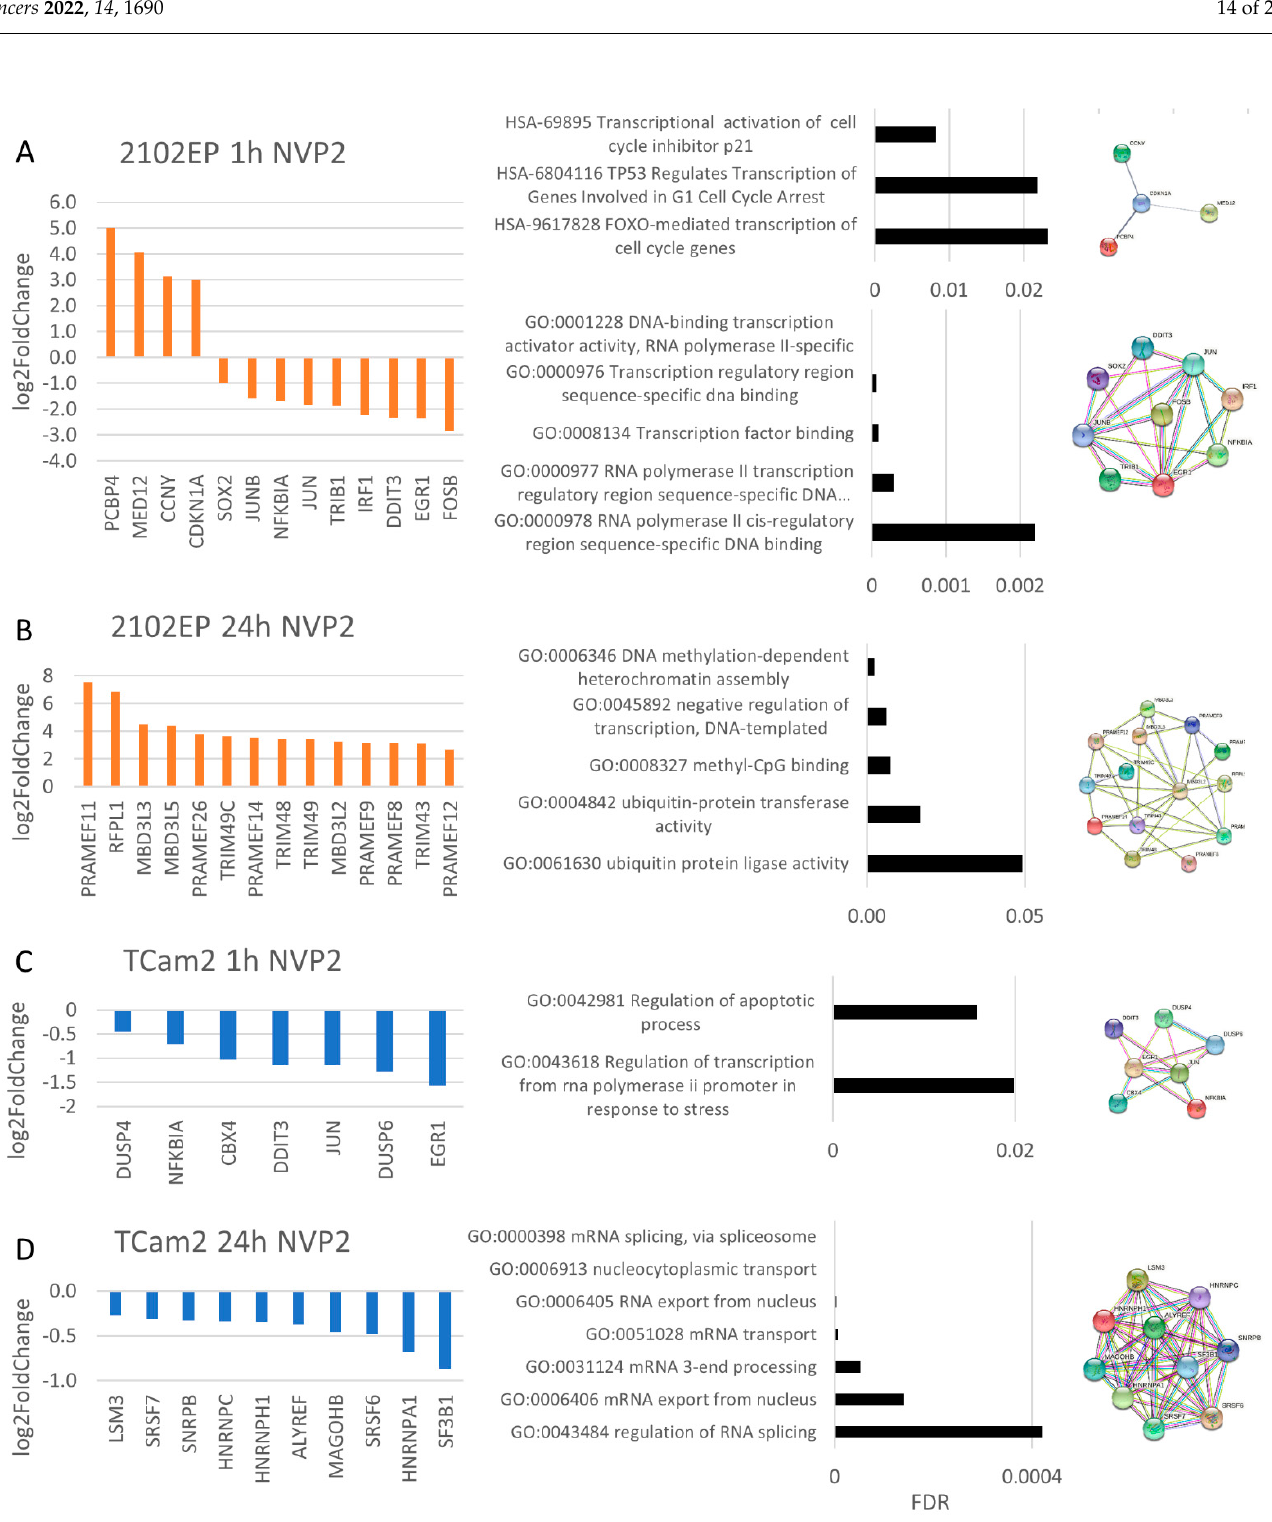
Figure 7. NVP2 treatment indicated cell-line-specific effects. RNA-Seq evaluation was performed via Reactome pathway analysis/Gene Ontology analysis and STRING interaction analysis in ( A ) 2102EP cells after 1 h of treatment, ( B ) 2102EP cells after 24 h, ( C ) TCam2 cells after 1 h and ( D ) TCam2 cells after 24 h. For all samples, n = 3.